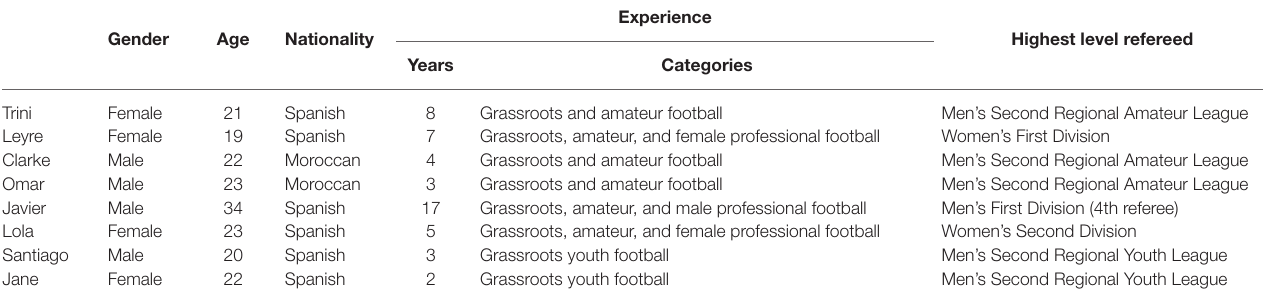
TABLE 1 | Participants’ main